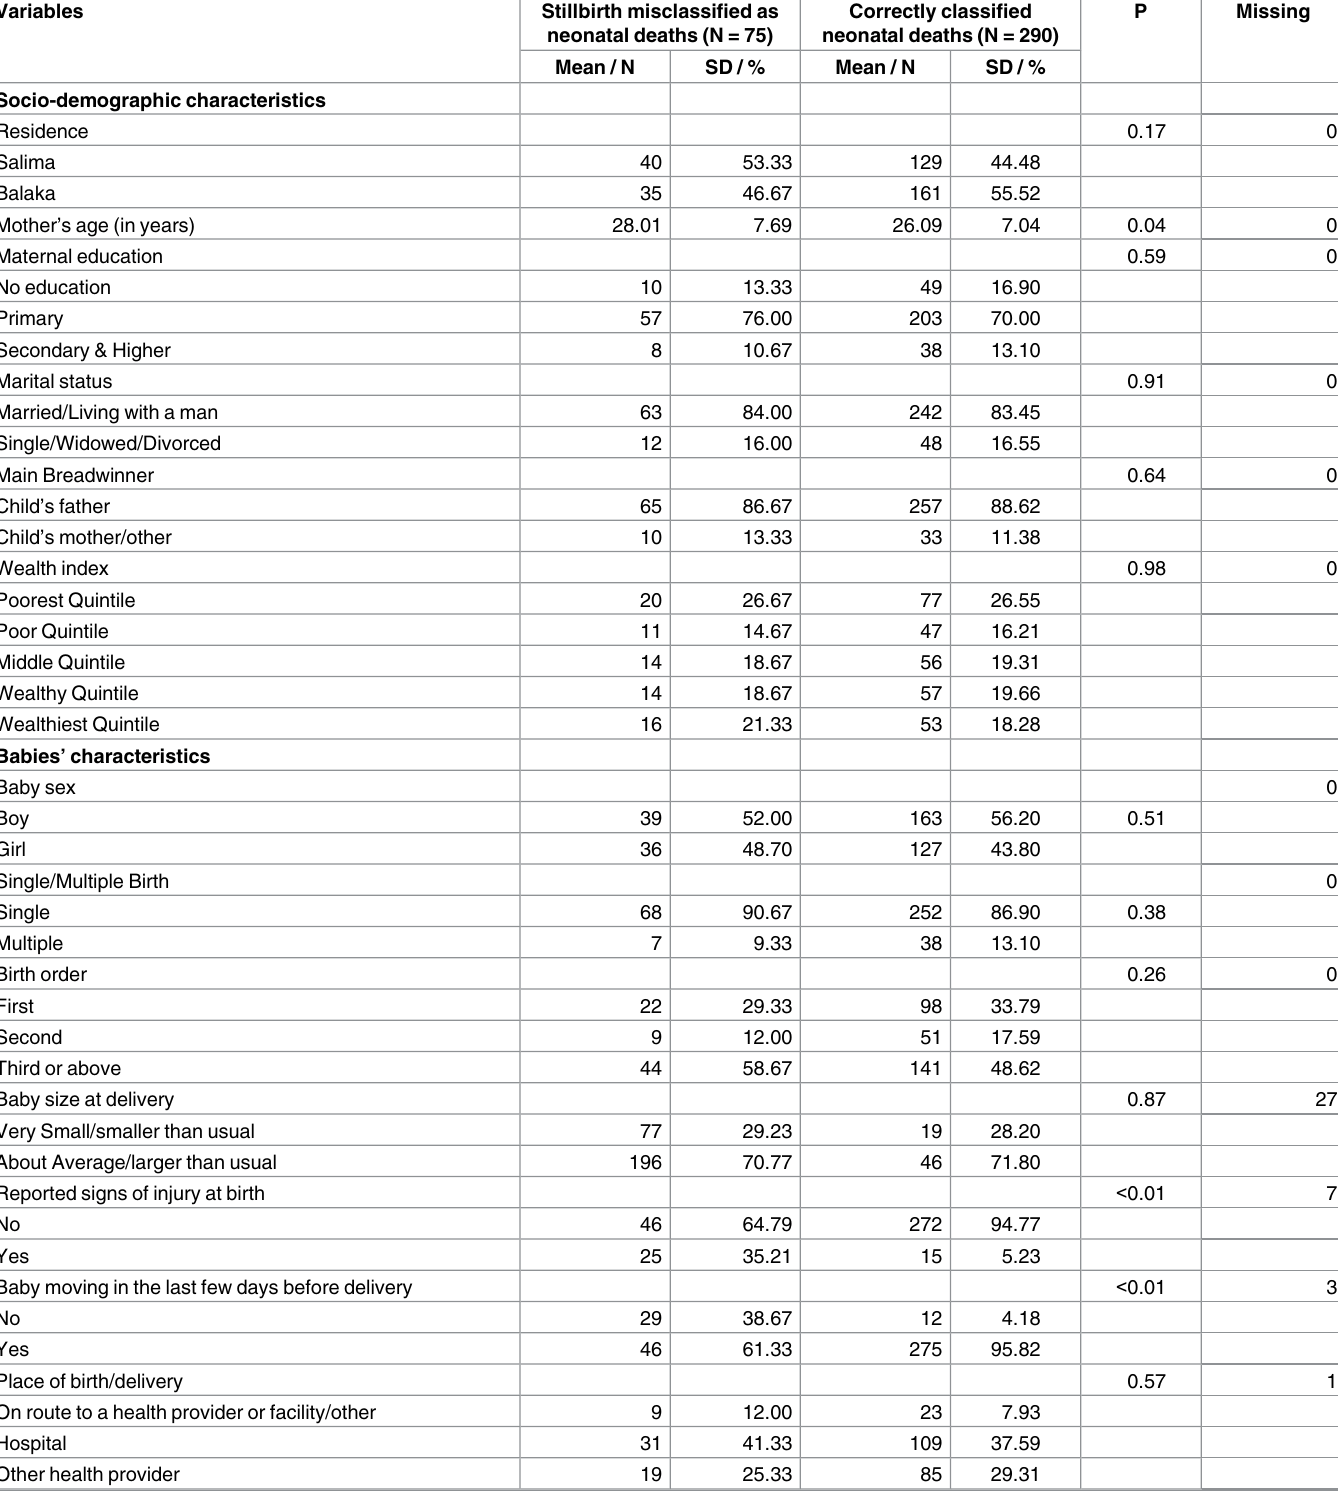
Table 3. Babies’, mothers’, socio-demographic, and survey’scharacteristics by FBH misclassification status in Malawi.